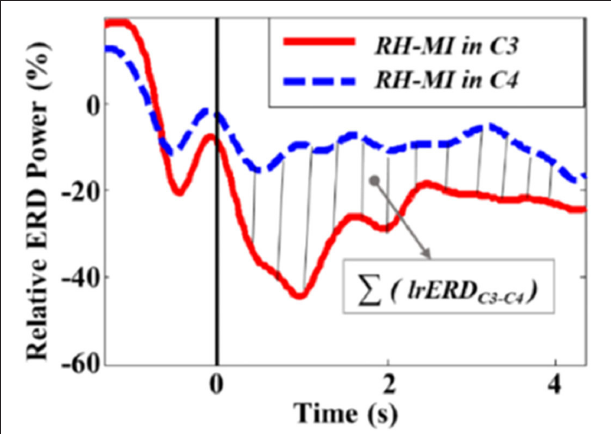
FIGURE 3 | lrERD calculation diagram of RH-MI training.